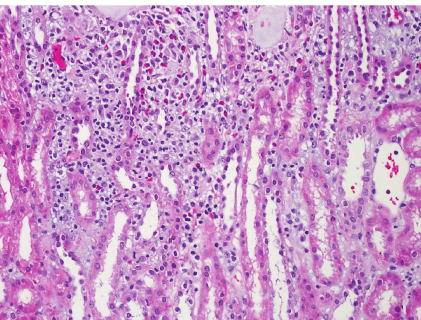
Figure 1: Renal cortex: the interstitium is expanded by edema and an inflammatory infiltrate containing lymphocytes, macrophages, and numerous eosinophils. H&E (200x magnification).